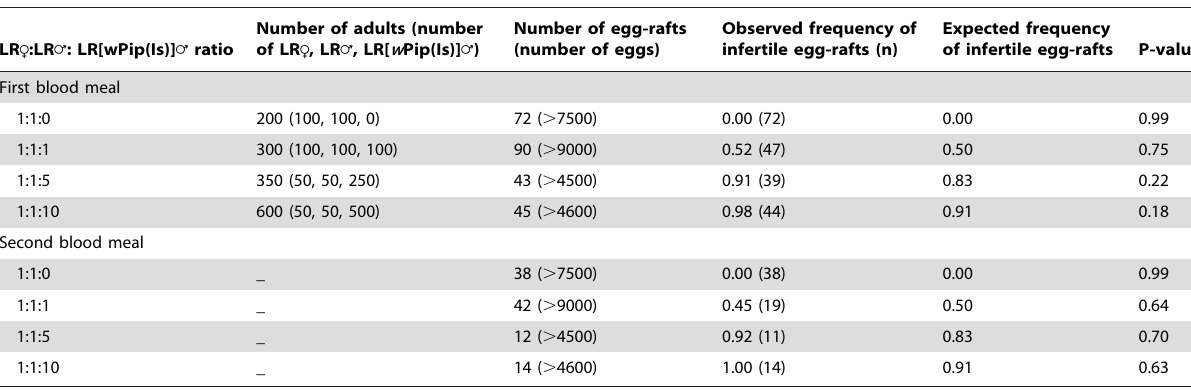
Table 5. Competition cages with different ratio of LR[ w Pip(Is)] males.